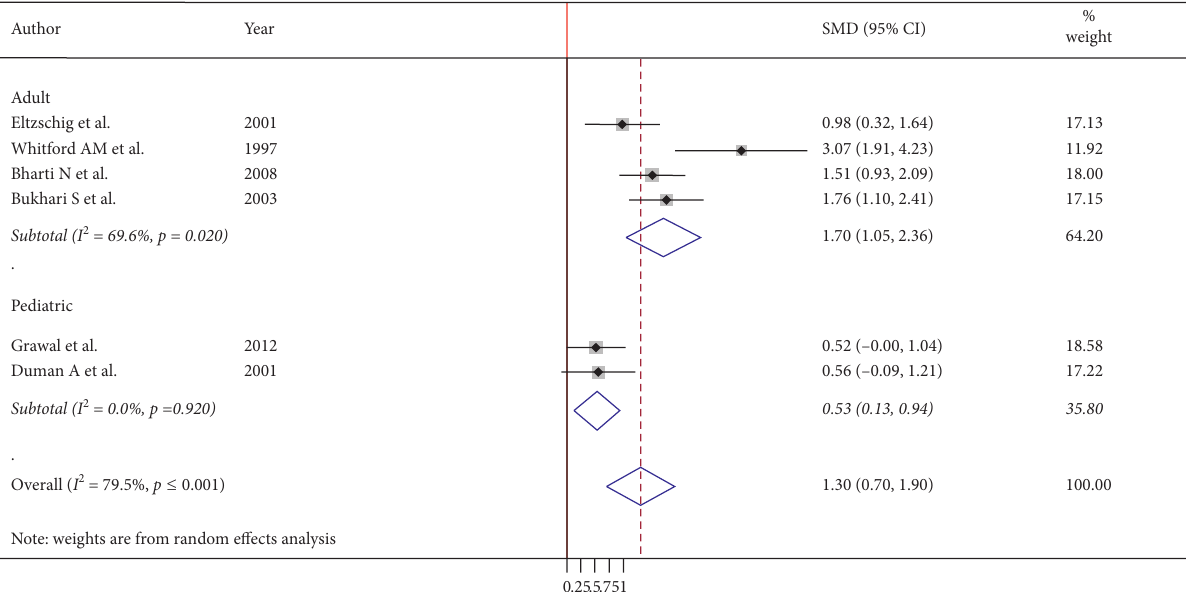
Figure 4: Subgroup analysis of IOP after ETT intubation and LMA insertion by the population